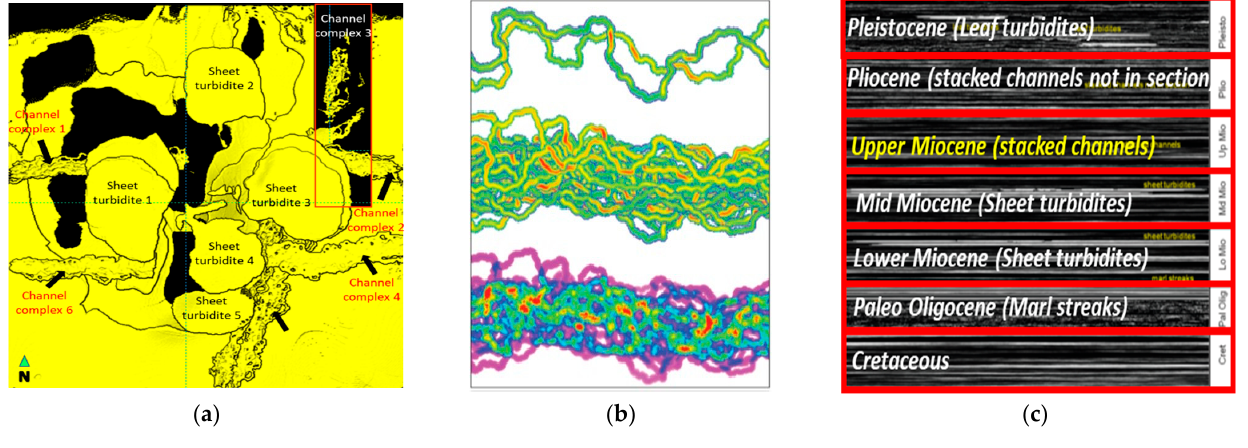
Figure 1. The stratigraphy of the SEAM dataset. ( a ) The overall SEAM Reservoir Model shows three major reservoirs: sheet turbidites, localized turbidite fans, and channel complexes. The red rectangle shows the area of study selected for channelized predictions. ( b ) Examples of intersecting channel complexes colored by volume of shale (vshale), with estimated distance 33 km. Modified after [8]. ( c ) Volume of shale at east – west section at Y = 20 k, showing the interval of interest highlighted by the red rectangle.